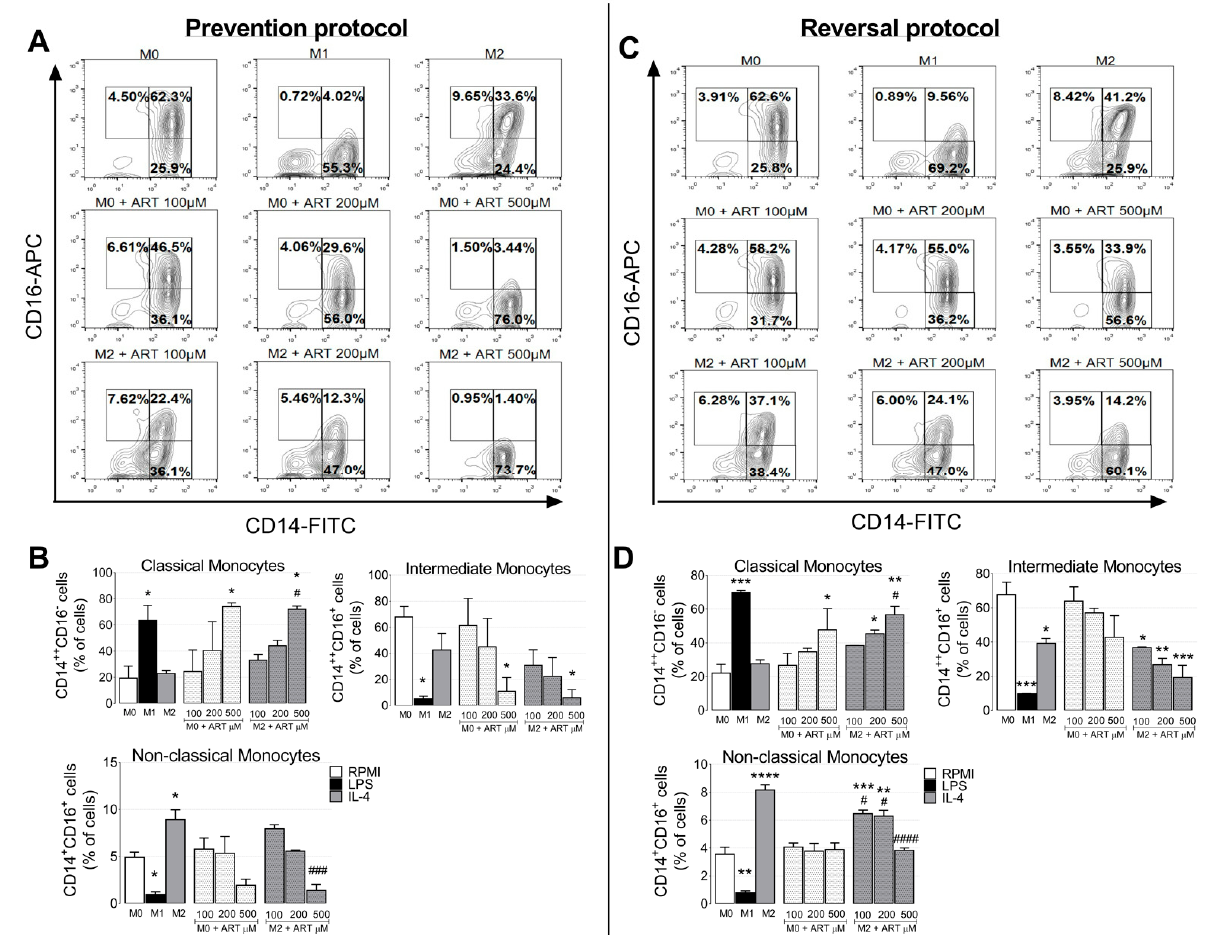
Figure 2. ART treatment induces an inflammatory phenotype of monocytes. In the prevention protocol, monocytes were treated with increasing doses of ART (100, 200, and, 500 µ M) for 24 h in the presence or not of IL-4 ( A , B ). In the reversal protocol ( C , D ), cells were treated with IL-4 for 6 h and ART was then added in fresh medium for an extra 18 h. Expression of cell surface markers were analyzed by flow cytometry, and cells were divided into three main subsets: ( i ) CD14 high CD16 − (classical monocytes), ( ii ) CD14 high CD16 + (intermediate monocytes), and ( iii ) CD14 − /low CD16 + (non-classical monocytes). Data represent mean ± SEM of at least three independent experiments performed in triplicate. Data were analyzed by ANOVA followed by Tukey post hoc. *, **, ***, and, ****, significantly different from control M0 cells (white bar) ( p < 0.05, <0.01, <0.001, and <0.0001, respectively). #, ###, and, ####, significantly different from M2 cells (grey bar). M0: Naive control monocytes maintained in RPMI 10%, M1: positive control for inflammatory monocytes maintained in LPS and, M2: immunosuppressive monocytes maintained in